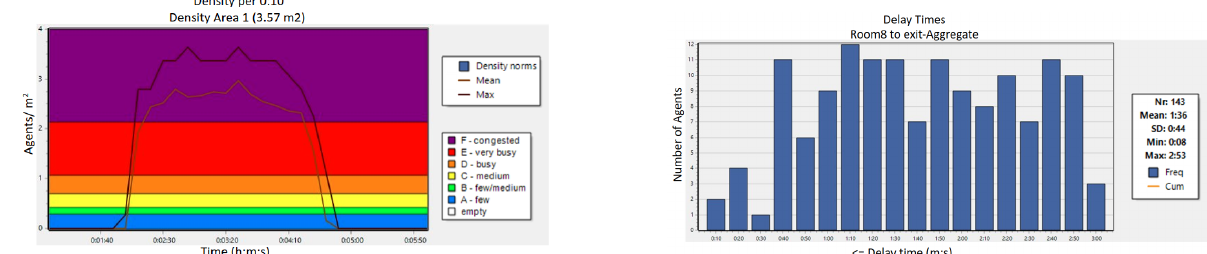
Figure 8: Left: Evacuation Density Area Crowded, Right: Evacuation Delay Distribution